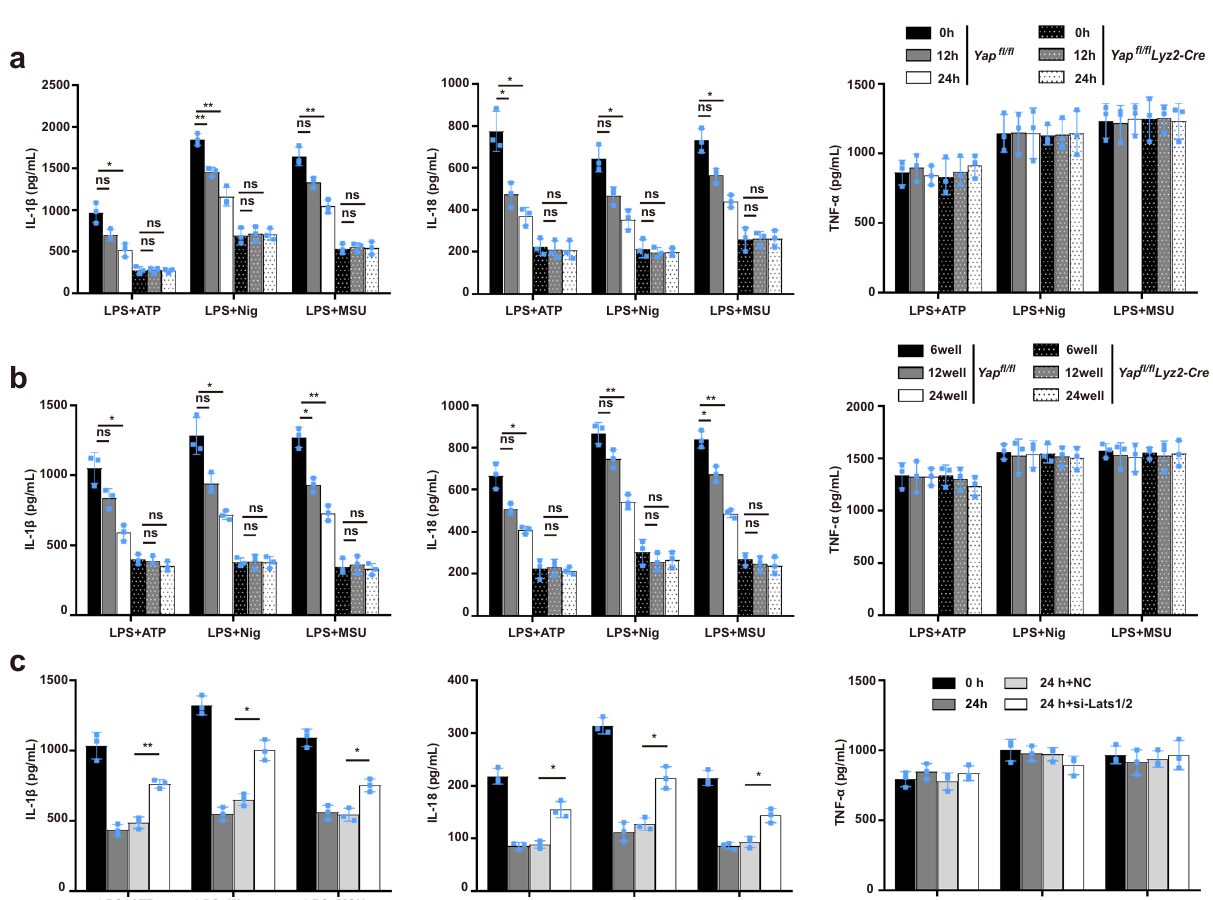
Fig. 3 Hippo signaling suppresses the NLRP3 in fl ammasome activation in a YAP-dependent manner. a , b ELISA of IL-1 β , IL-18, and TNF- α in supernatants of mouse peritoneal macrophages from Yap fl / fl lyz2-Cre and Yap fl / fl mice treated with serum starvation for indicated times ( a ) or seeded into different con fl uence ( b ), then applied with indicated stimuli (for a , mean ± SD, two-way ANOVA with Bonferroni test, left panel:12h and 24 h vs. 0 h in Yap fl / fl or Yap fl / fl lyz2-Cre group, ns = 0.1243, * P = 0.0267, ns > 0.9999, ns > 0.9999, ** P = 0.0065, ** P = 0.0055, ns > 0.9999, ns > 0.9999, ns = 0.0661, ** P = 0.0069, ns > 0.9999, ns > 0.9999 in sequence; middle panel:12h and 24 h vs. 0 h in Yap fl / fl or Yap fl / fl lyz2-Cre group, * P = 0.0448, * P = 0.0261, ns > 0.9999, ns > 0.9999, ns = 0.06, * P = 0.0113, ns > 0.9999, ns > 0.9999, ns = 0.0557, * P = 0.0127, ns > 0.9999, ns > 0.9999 in sequence; n = 3 independent experiments. For b , mean ± SD, two-way ANOVA with Bonferroni test, left panel: 12-well and 24-well vs. 6-well in Yap fl / fl or Yap fl / fl lyz2-Cre group, ns = 0.1743, * P = 0.0239, ns > 0.9999, ns = 0.5177, ns = 0.0861, * P = 0.0408, ns > 0.9999, ns > 0.9999, * P = 0.0115, ** P = 0.0021, ns > 0.9999, ns > 0.9999 in sequence; middle panel: 12 h and 24 h vs. 0 h in Yap fl / fl or Yap fl / fl lyz2-Cre group, ns = 0.0969, * P = 0.0386, ns > 0.9999, ns > 0.9999, ns = 0.1, ** P = 0.0038, ns > 0.9999, ns > 0.9999, * P = 0.0205, ** P = 0.0032, ns > 0.9999, ns > 0.9999 in sequence; n = 3 independent experiments). c ELISA of IL-1 β , IL-18, and TNF- α in supernatants from mouse peritoneal macrophages silenced of Lats1/2 and treated with serum starvation for indicated times, then applied with indicated stimuli (mean ± SD, two-way ANOVA with Bonferroni test, si Lats1/2 24 h vs. si Ctrl 24 h, left panel: ** P = 0.0031, * P = 0.0107, * P = 0.0492 in sequence; middle panel: * P = 0.0492, * P = 0.0393, * P = 0.0478 in sequence; n = 3 independent experiments). Source data are provided as a Source Data fi